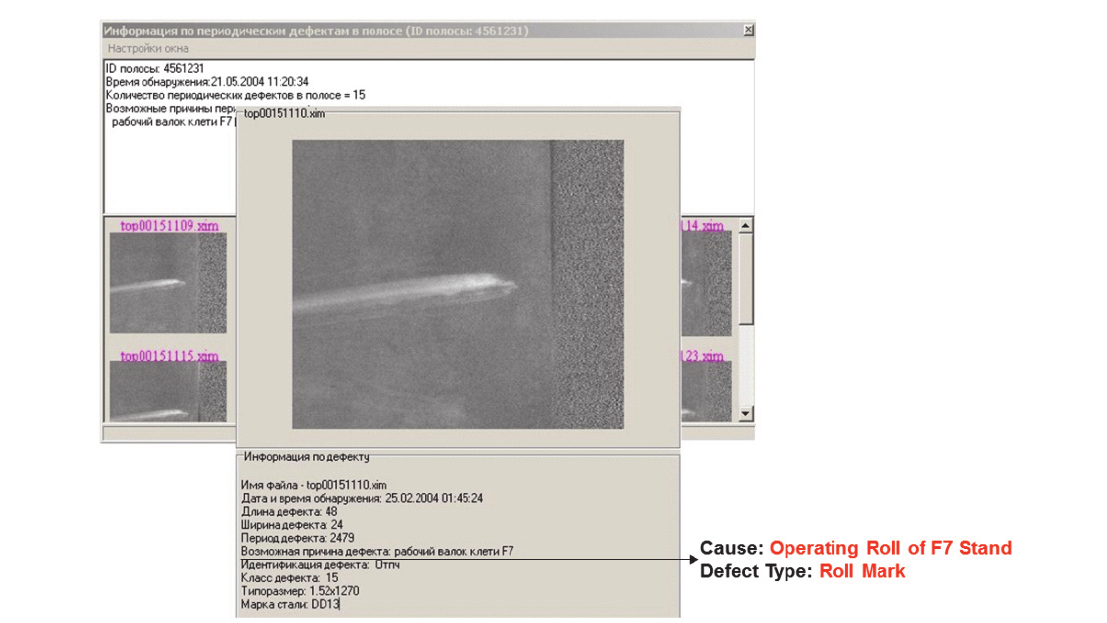
Figure 4: Visualization of application of processing of periodical